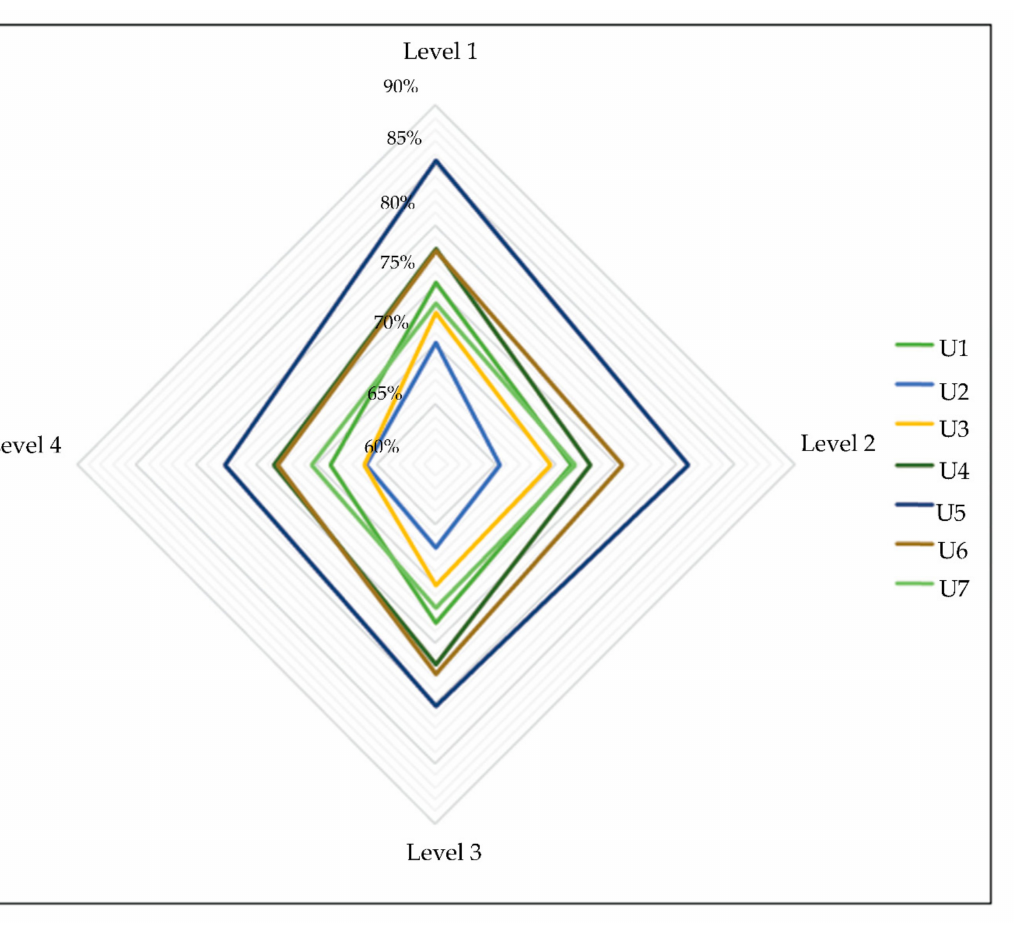
Figure 11. Scope of the units with respect to the EMGCI. Source: own